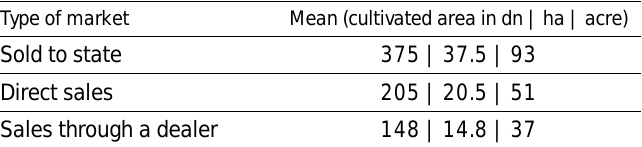
Table 4. Type of Marketing Channels Versus Mean Cultivated Area in Dunums